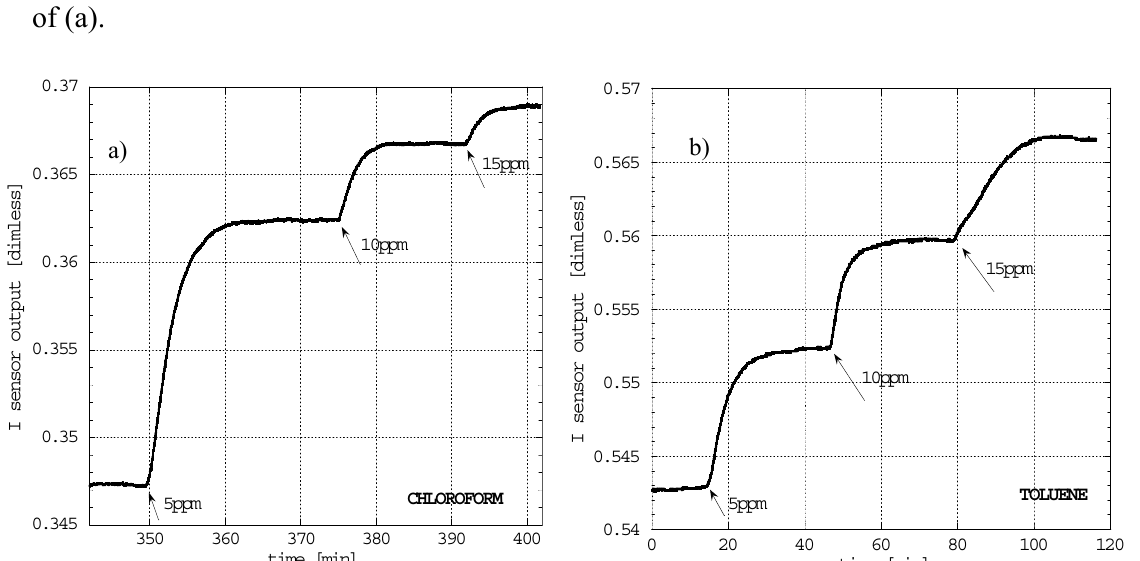
Figure 18. (a) Sorption curve for chloroform in water at 25 °C. Each step corresponds to a 5 ppm addition of solute in water;(b) Toluene sorption curve in the same test conditions of